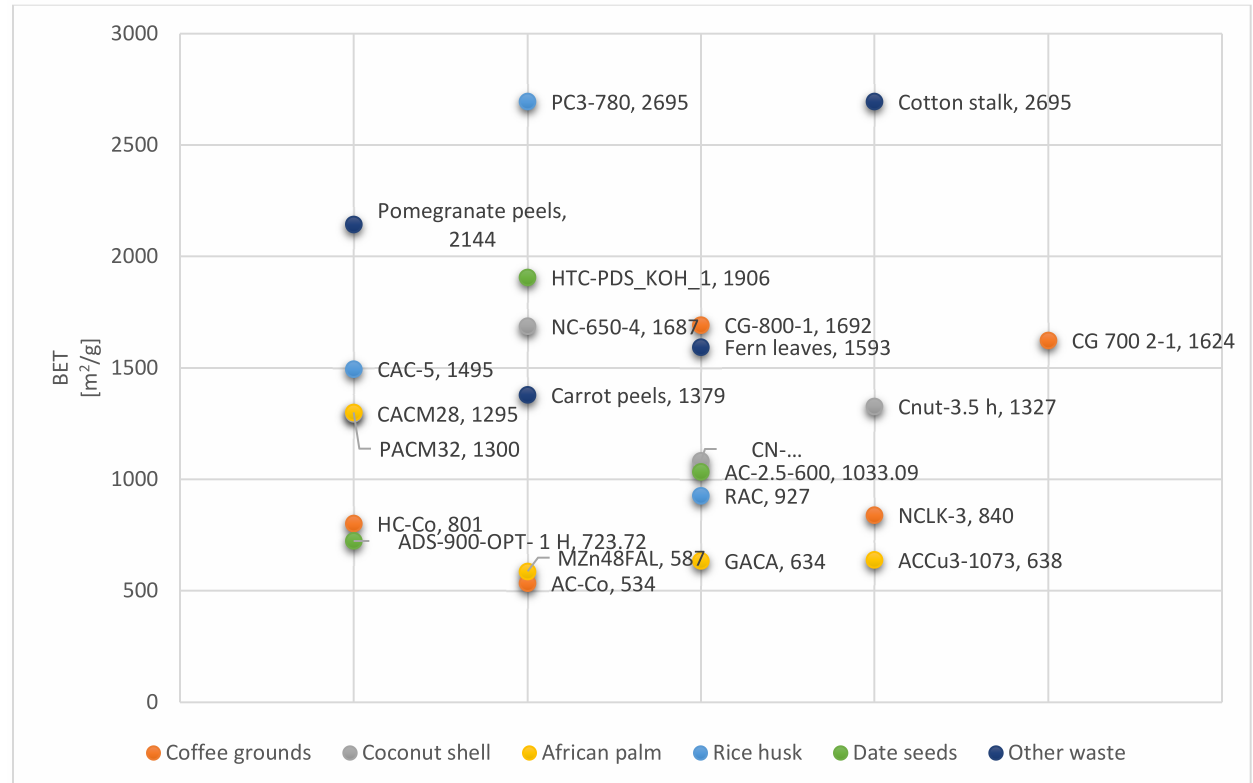
Figure 8. The specific surface area of selected bioadsorbents characterized in the